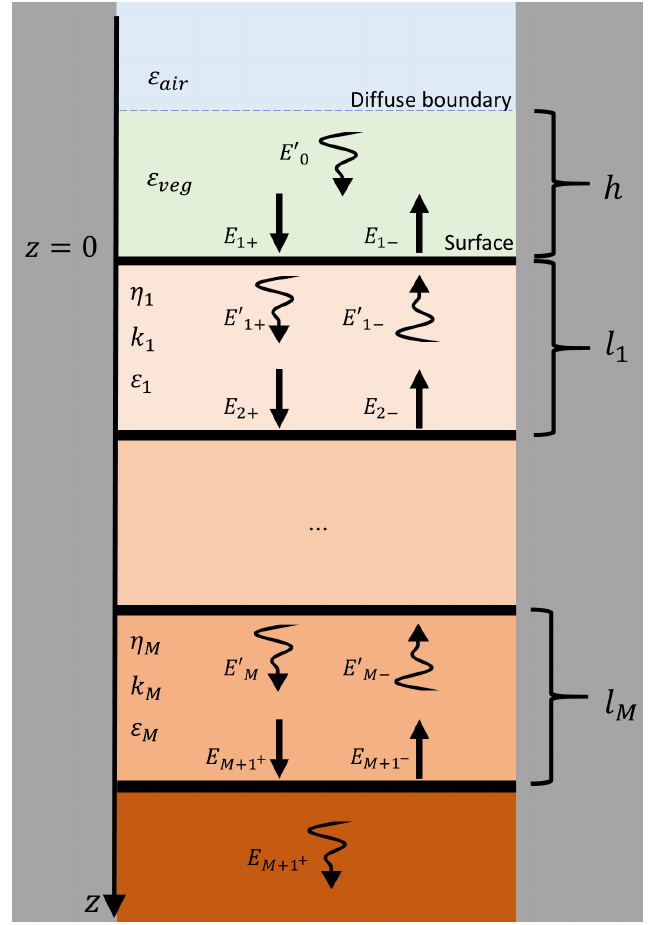
Figure 1. Representation of propagation and reflection processes within a discretized soil moisture profile. To account for polarization and angle for oblique incidence case, the fields are separated into transverse and longitudinal components with respect to the surface normal (the z -direction).